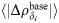
Relationships between phase-locking modulations and the structural or functional connectivity of the stimulated site vary with working point.(A) Difference Δrs in the strength of the correlation between the average absolute baseline band PLV changes 〈|Δρδibase|〉 and structural (sistruc) or functional (sifunc) node strength, plotted as a function of the baseline drive PEbase-PE* for a coupling C = 2.5. The difference is defined such that when the curve is positive, overall coherence modulations exhibit a stronger correlation with functional rather than structural strength. The arrows mark the locations of the different working points studied in detail in the main or SI Text. (B) A schematic summarizing how structural sstruc or functional sfunc strength are related to either baseline or excited band PLV changes for different dynamical regimes. As the background drive varies from low (WP1) to medium (WP2) to high (WP3), the oscillatory state of the system changes, and so does the association of different phase-locking modulations to structural or functional network properties.